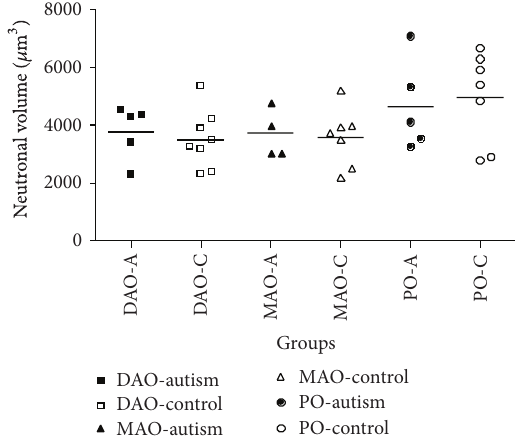
F3:Scatterplotshowingtheperikaryalvolumefortheinferior olivary complex by group (DAO: dorsal accessory olive; MAO: medial accessory olive; PO: principle olive). Although there were no signi�cant di�erences found, the PO neuronal volume was quite variable in both autistic and control brains. A: autism, C: